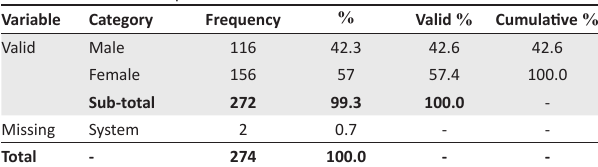
16.1 % compared with 1.5 % of Indian descendant students.